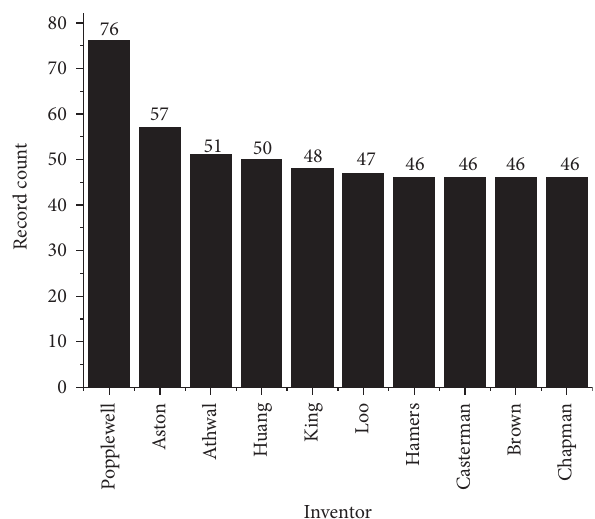
Figure 5: Main inventors related to the number of